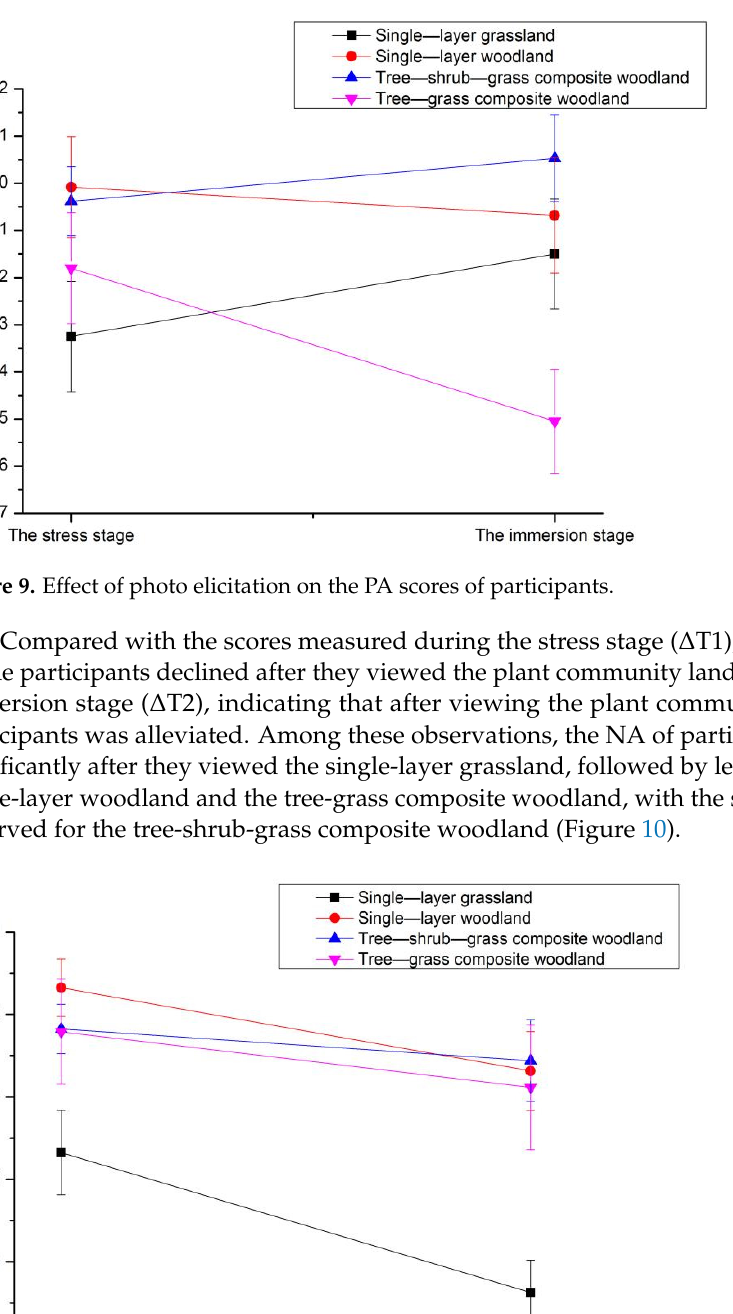
Figure 10. Effect of photo elicitation on the NA scores of the participants.